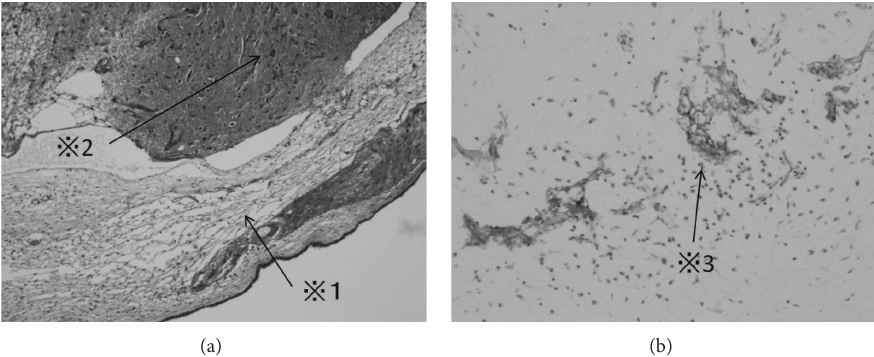
Figure 4: (a): glial cells surrounded by the respiratory epithelium with vessels and connective tissue. n 1: respiratory mucosa, n 2: glial cells (b): intense staining of glial elements for glial fibrillary acidic protein (GFAP). n 3: stained